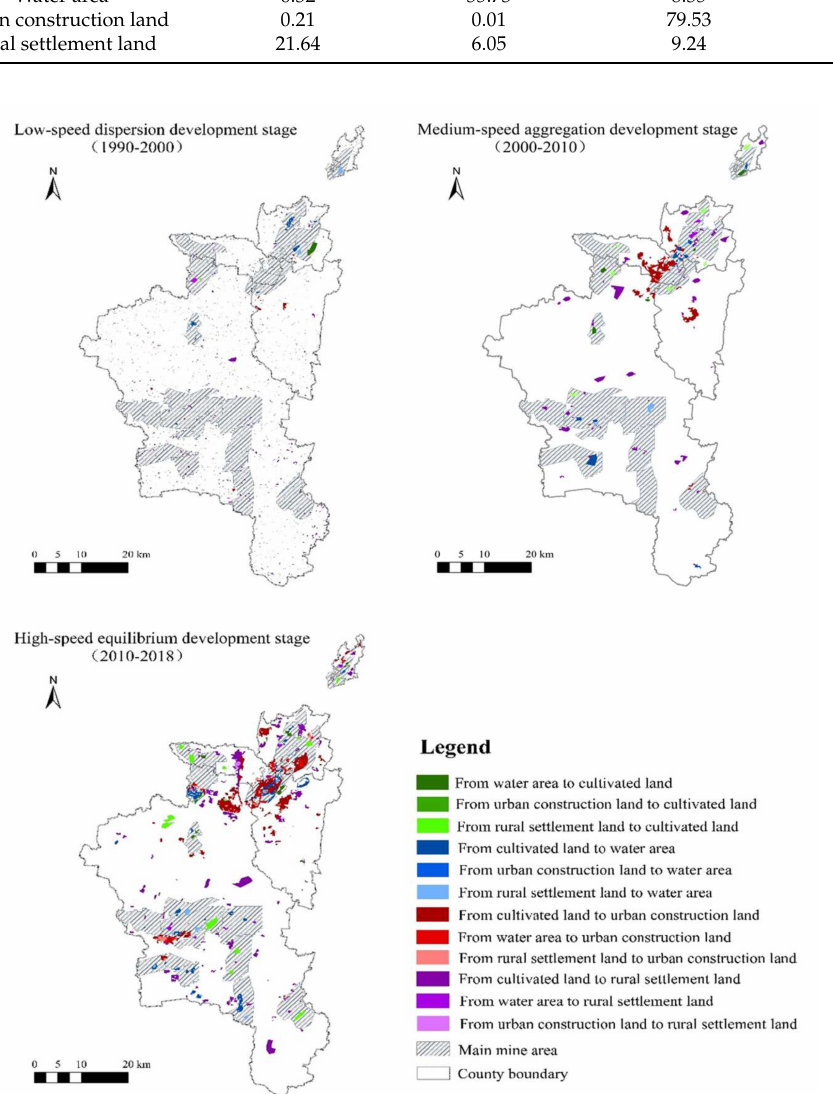
Figure 5. Land use type conversion spatial distribution map of Huaibei City (note: the figure is drawn by the